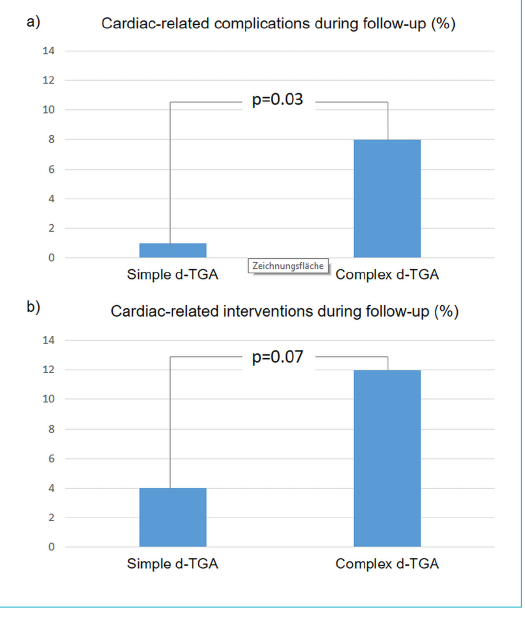
Figure 1: Comparison of cardiovascular-related events during fol- low-up (simple vs. complex anatomy). Differences in the incidence of patients suffering from cardiac-related complications or having undergone cardiac-related interventions during follow-up between patients with simple vs. complex dextro-transposition of the great arteries (d-TGA). The comparison was assessed by means of a chi-square test.